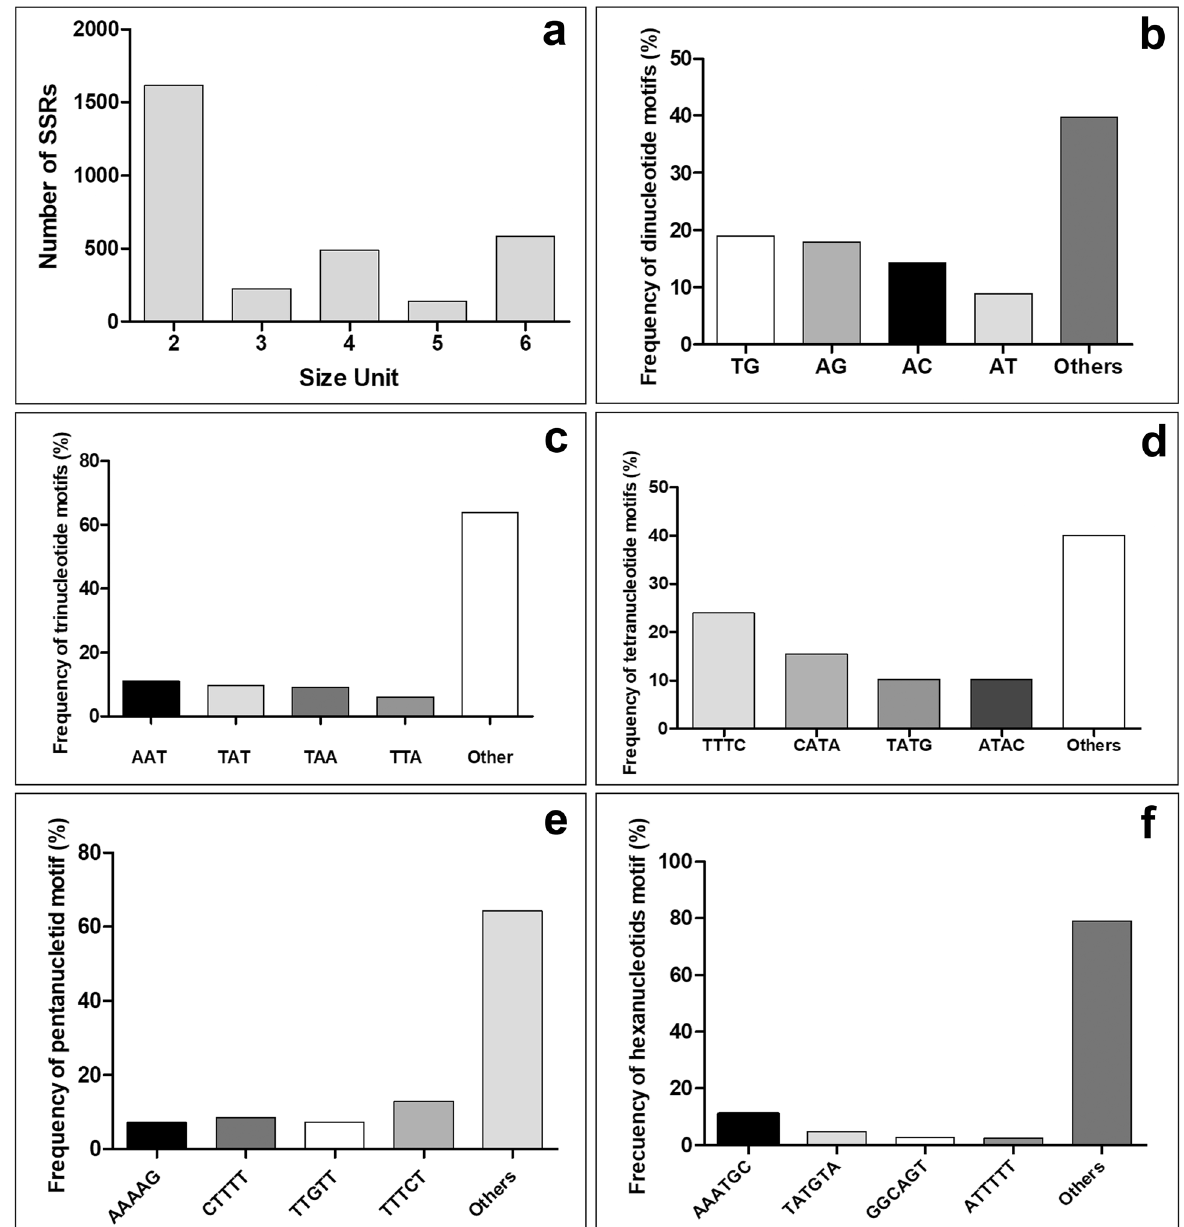
Figure 3. (a) Number of total frequent motifs of SSRs. (b) Fequency of dinucleotids motifs (%) most abundant (c) trinucleotides (d)tetranucleotides, (e) pentanucleotides, and (f) hexanucleotides motifs found in S. coryne